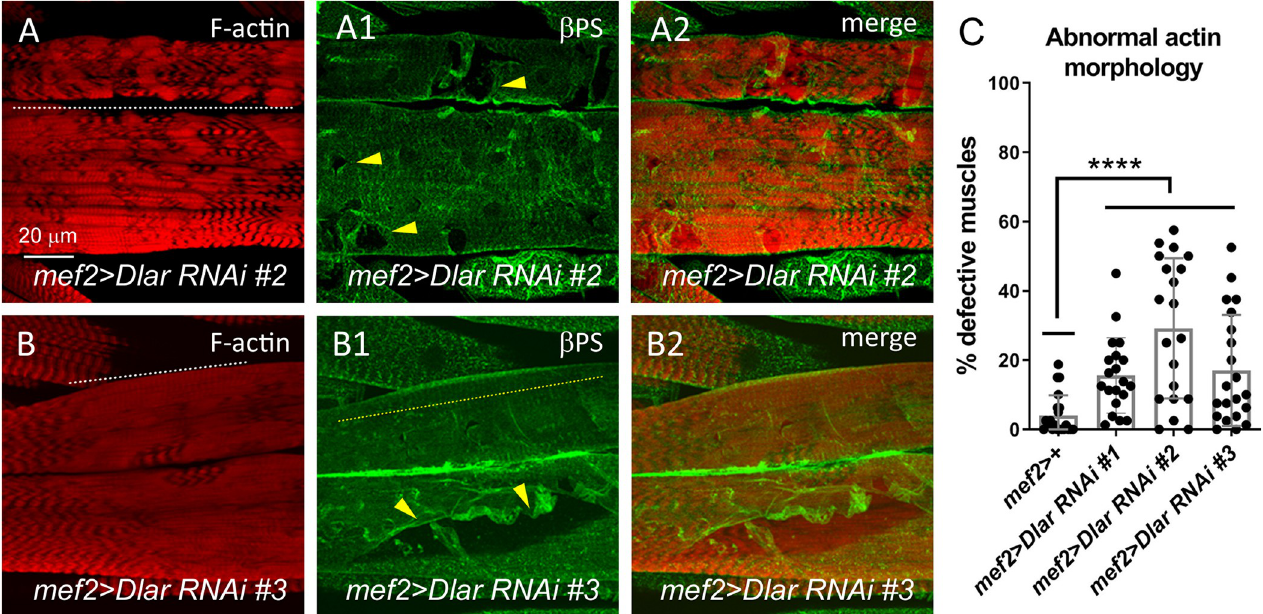
Fig 4. β PS is mislocalized in additional Dlar RNAi lines. (A-B2) Confocal micrographs of L3 ventral longitudinal muscles. Anterior is left in all images. F- actin (A,B) or β PS integrin (A1,B1) staining in mef2 > Dlar RNAi #2 (A-A2) or mef2 > Dlar RNAi #3 (B-B2) muscles reveal a general loss of sarcomeric patterning (white dotted line) and integrin mislocalization (yellow dotted line). The integrity of the sarcolemma is also disrupted in both RNAi lines (A1,B1, yellow arrowheads). (C) Bar and scatter chart showing the percentage of defective muscles. Mean +/- SD. ���� , p < 0.01. N � 20.